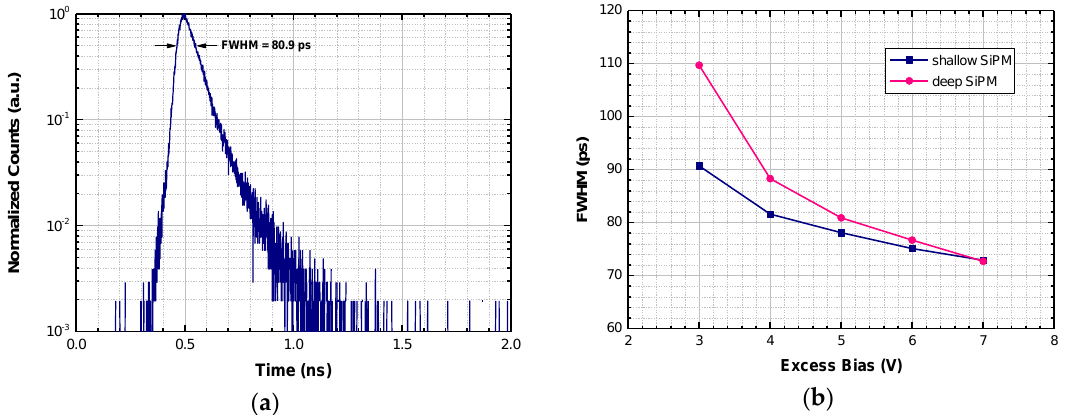
Figure 7. ( a ) Single-photon timing response at 850 nm of a deep SiPM operated at 5 V excess bias; ( b ) Measured timing jitter (FWHM) of the two developed SiPMs as a function of excess